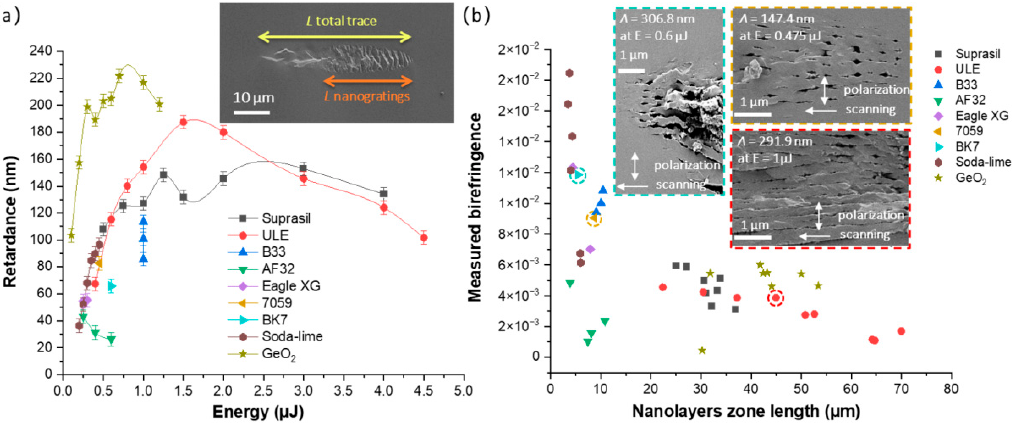
Figure 4. ( a ) The measured optical retardance R and ( b ) corresponding birefringence ( B = R / L nanogratings ) of different glasses (insets are the SEM images of BK7, 7059, and ULE). Experimental conditions: 1030 nm, 800 fs, 0.6 NA, pulses densities f / v = 10 3 pulse/ µ m (ULE, GeO 2 , AF32, B33), f / v = 10 4 pulse/ µ m (soda-lime, Eagle XG), f / v = 10 5 pulse/ µ m (50 kHz for 7059 and 25 kHz for BK7), 250 fs, f / v = 500 pulse/ µ m (Suprasil), Xx writing